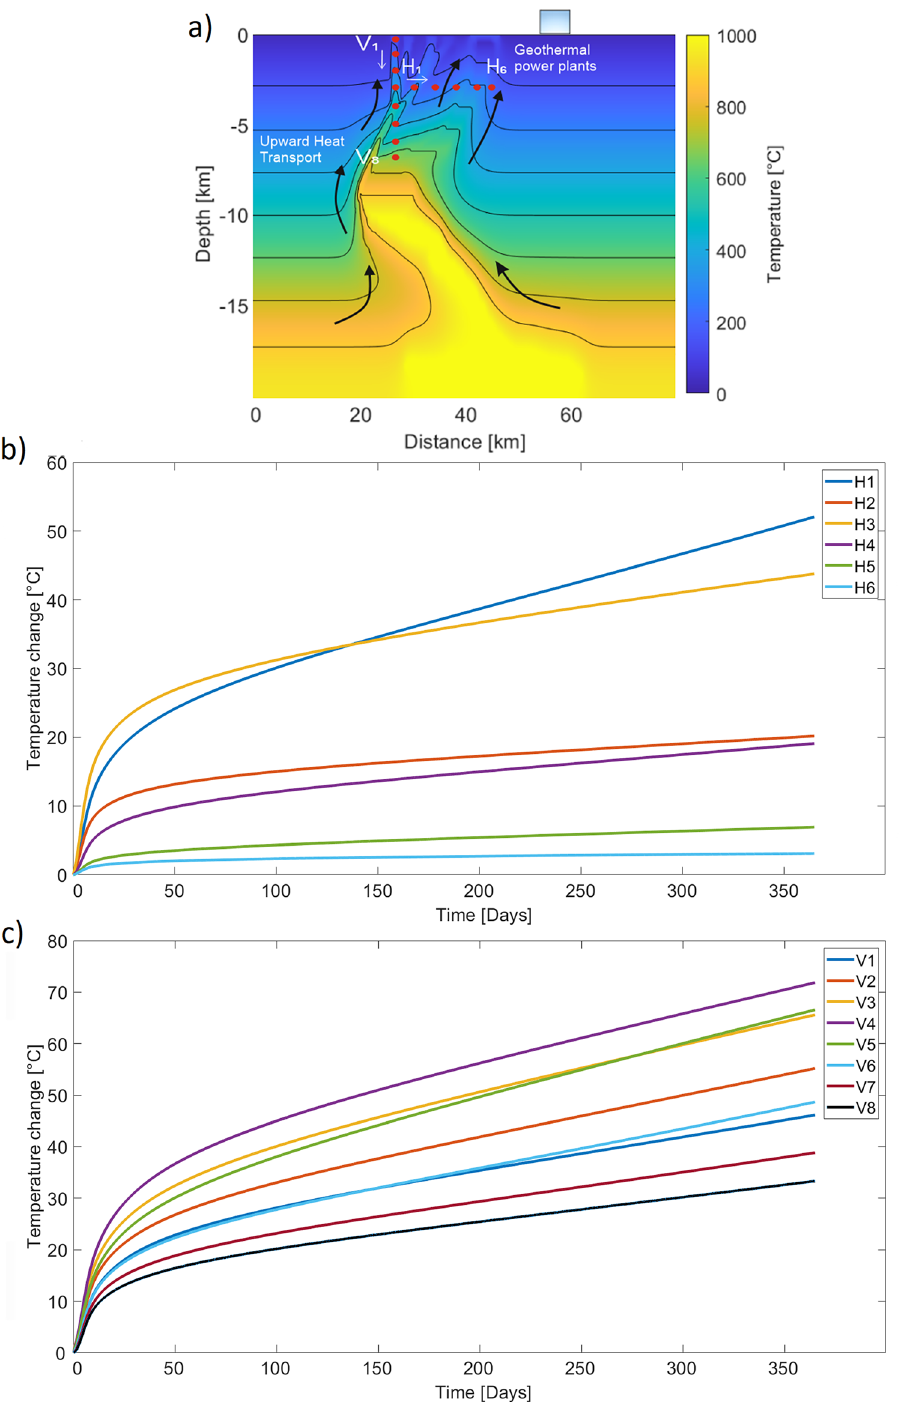
Figure 6. Temperature profiles. ( a ) Temperature distribution at 365 simulation day. The red dots indicate the location of the vertical and horizontal profiles. ( b ) Horizontally aligned temperature profiles (H1–H6) with a vast difference in temperature distribution. ( c ) Nine temperature distribution profiles show the temperature increase from top (V1) to bottom